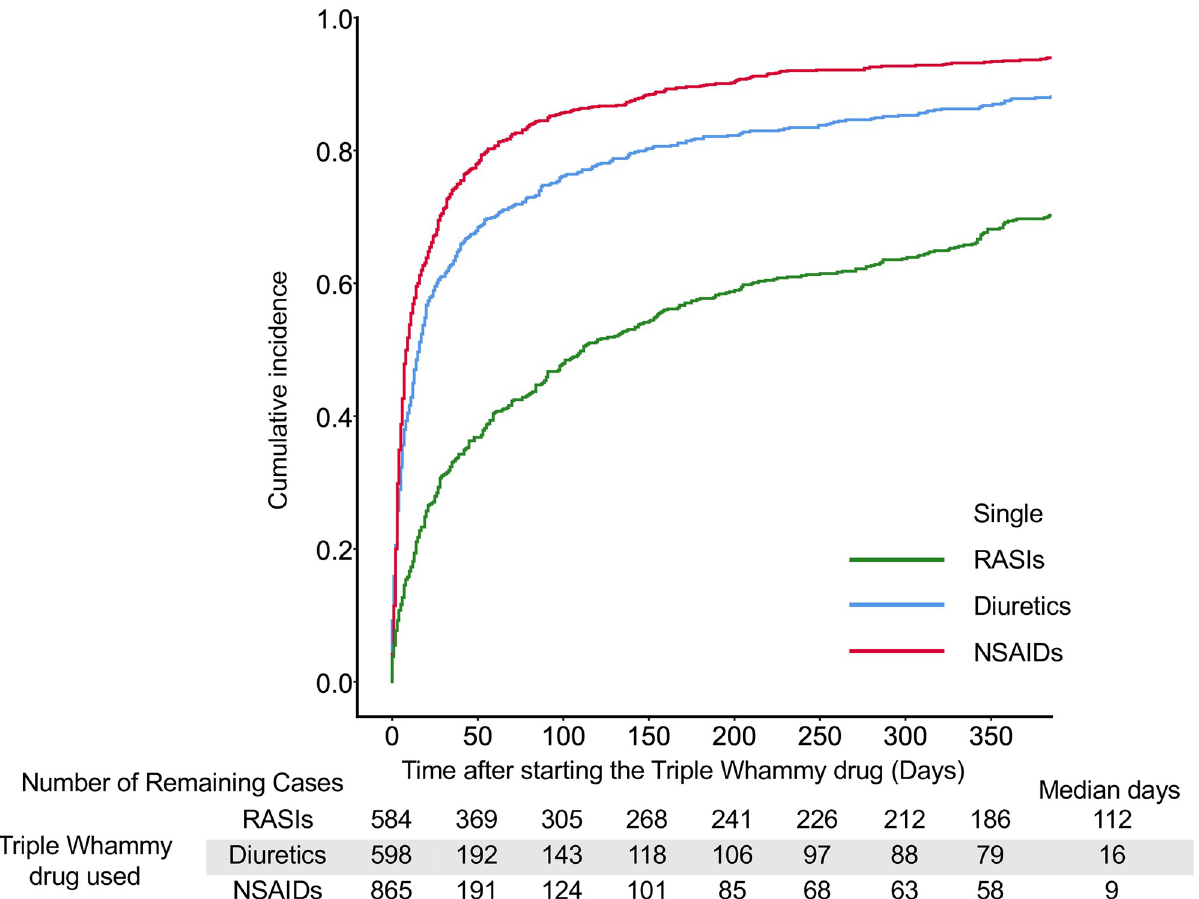
Fig 3. The cumulative incidence with TW drugs in single drug groups. Median days indicate the date when the cumulative failure rate reached 50%.